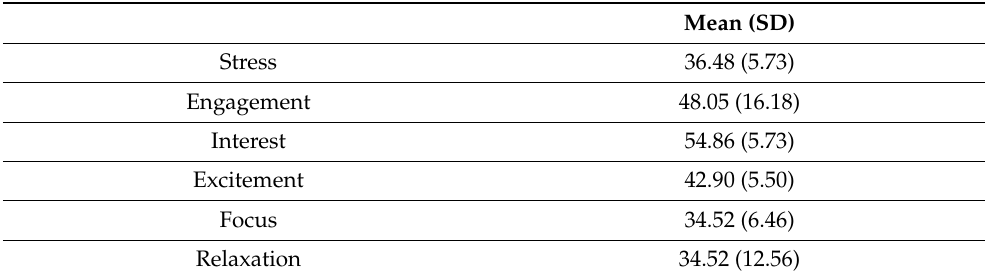
Table 4. Emotive reactions and user experience while the video game is developed, mean and standard deviations (SD).